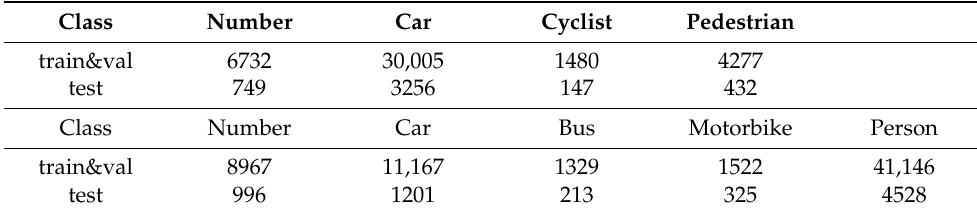
Table 2. Dataset partition